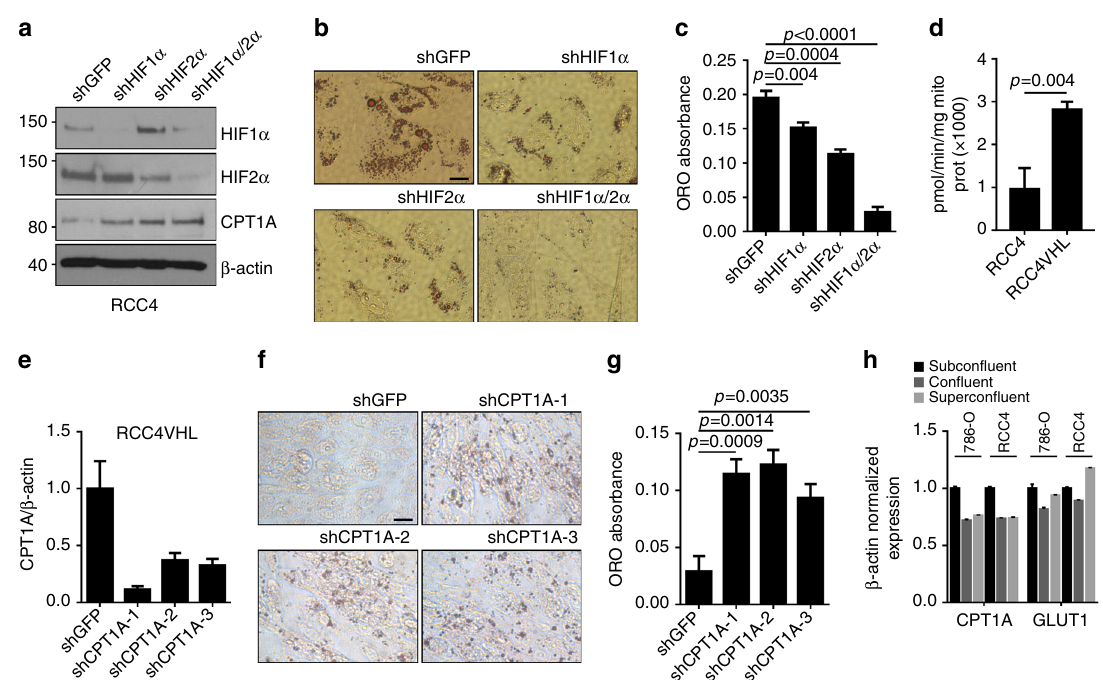
Fig. 4 CPT1A repression controls lipid deposition in ccRCC cells. a Western blot of RCC4 cell lysates expressing shRNA to HIF1 α and HIF2 α decorated with antibodies to HIF1 α , HIF2 α , CPT1A, and β -actin. b Photomicrographs of RCC4 cells with HIF1 α and HIF2 α knockdown stained for Oil Red O. c Quanti fi cation of Oil Red O staining of cells in b . d CPT1A activity measurement in RCC4 and RCC4 VHL mitochondria. e Quantitative real-time PCR of CPT1A (qRTPCR) expression in RCC4 VHL cells expressing three different CPT1A shRNA constructs. f Photomicrographs of Oil Red O-stained RCC4 VHL cells with CPT1A knockdown. Bar = 10 μ m. g Quanti fi cation of cells in e . h Quanti fi cation of CPT1A and GLTU1 expression in subcon fl uent, con fl uent, or supercon fl uent